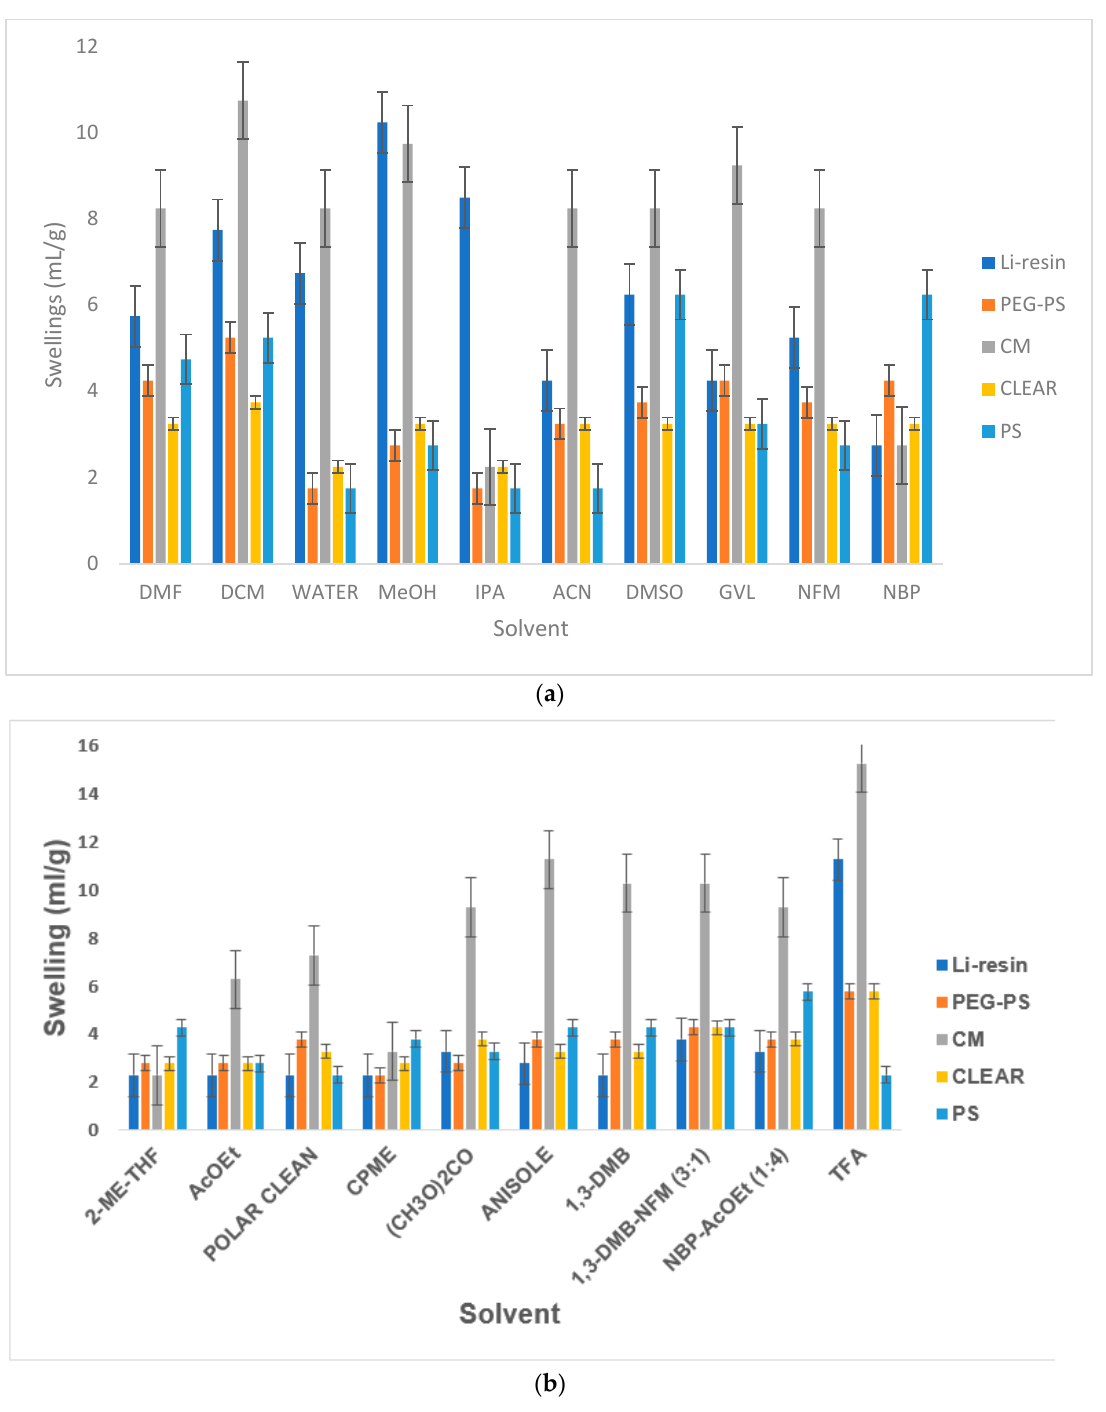
Figure 5. ( a , b ) Swelling of resins in different solvents. Amino-Li-resin swelled better than PS and PEG-PS but a little less than CM in DMF (#1), which is the most used solvent for SPPS both in research and industry. Although DMF is not a green solvent, it can be beneficial since it brings about enhanced swelling with respect to PS, but without a disproportionate increase in the consumption of solvents in the different steps of SPPS, particularly in the washes. In DCM (#2), which is considered more hazardous than DMF, the same trend was observed. Generally, amino-Li-resin swelled well in protic polar solvents such as H 2 O (#3), MeOH (#4), and IPA (#5), this making this support highly suitable for biochemical assays involving these solvents [49].